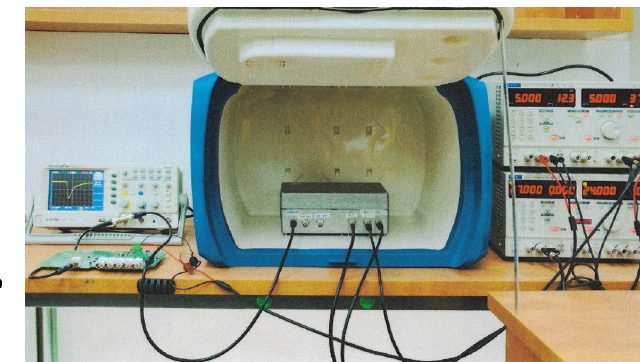
Fig. 9. The measuring setup.